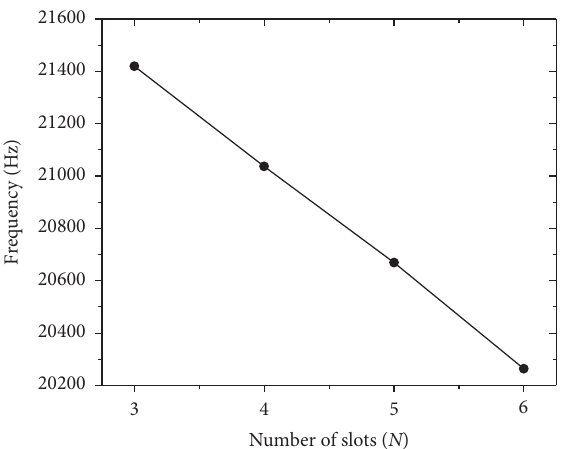
Figure 6: The effect of the number of spiral grooves on frequency of the compound horn.